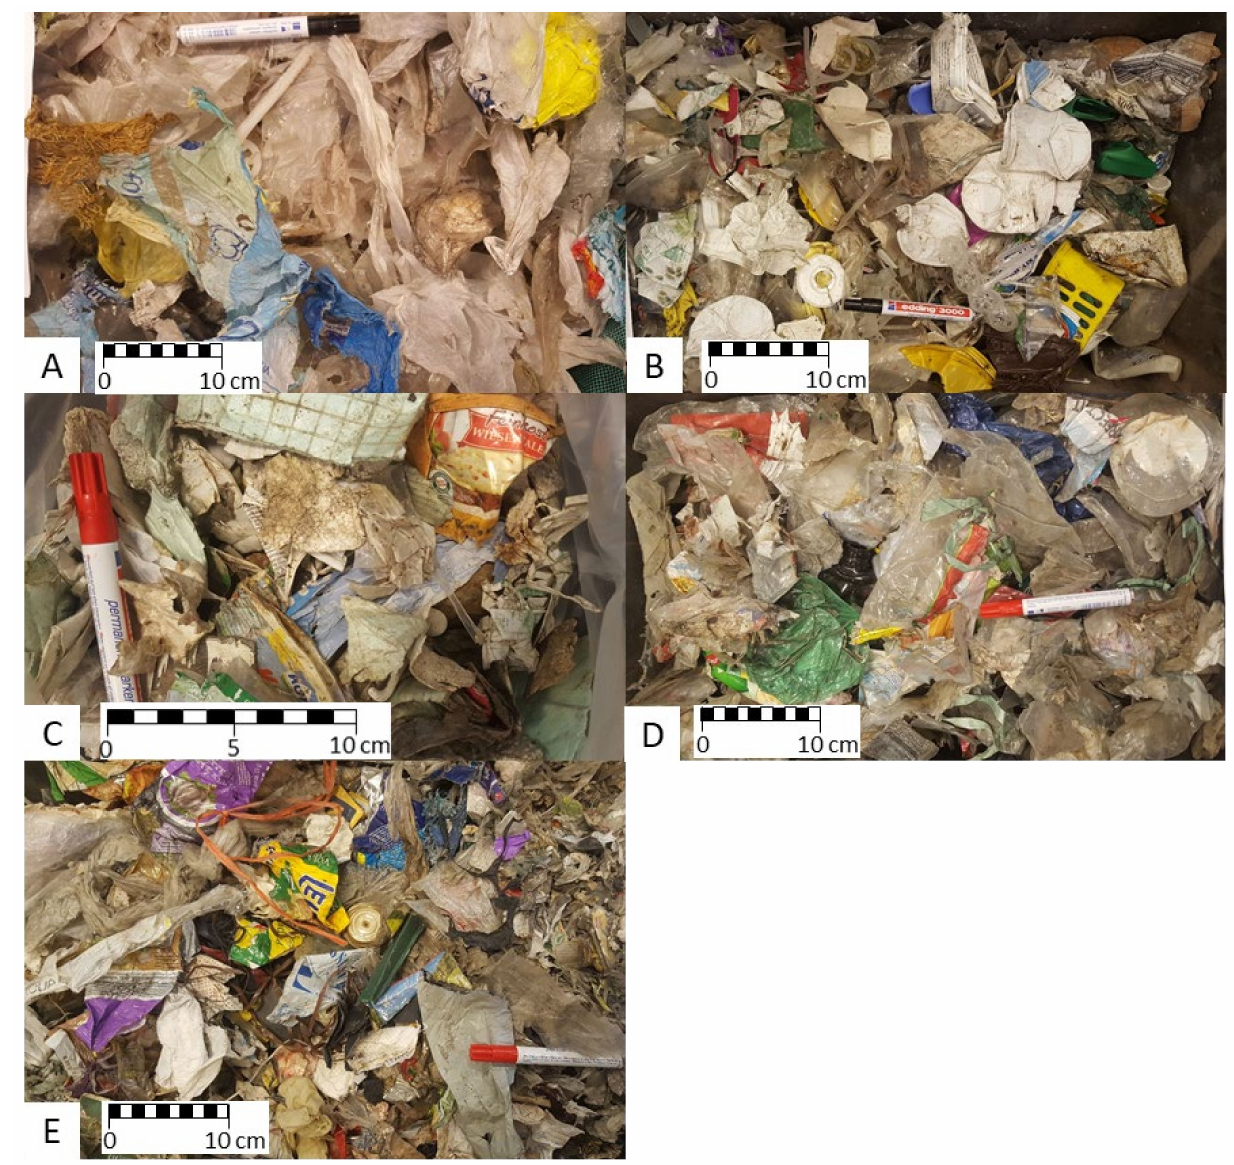
Figure A4. Exemplary photos of plastic types sorted with NIR: PE— A ; PP— B ; PET— C ; PS— D ; and others— E